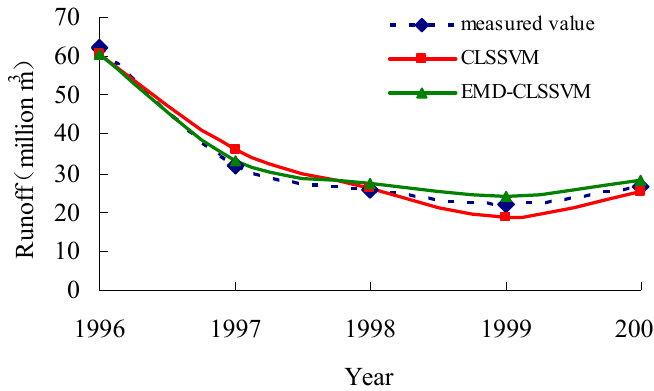
Figure 5. Prediction results of annual runoff for Shangjingyou station. CLSSVM: chaotic least squares support vector machine; EMD-CLSSVM: EMD-based chaotic LSSVM.